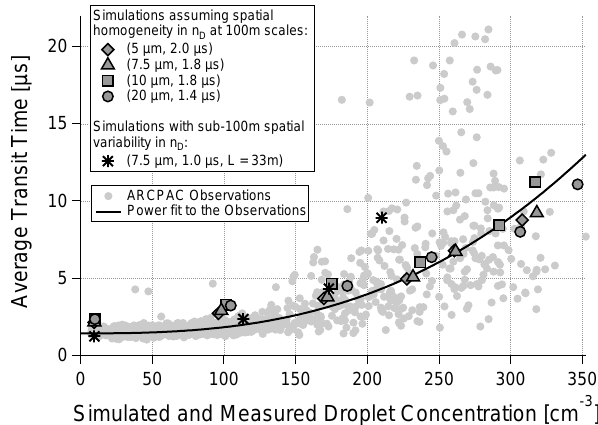
Fig. 12. Simulated error in volume mean diameter ( D V ) as a func- tion of prescribed droplet concentrations. Droplet sizing uncertainty at low droplet concentrations is < 10%. Smaller droplets exhibit greater relative oversizing errors due to coincidence. Sub-sample variability in droplet concentrations also increases the oversizing